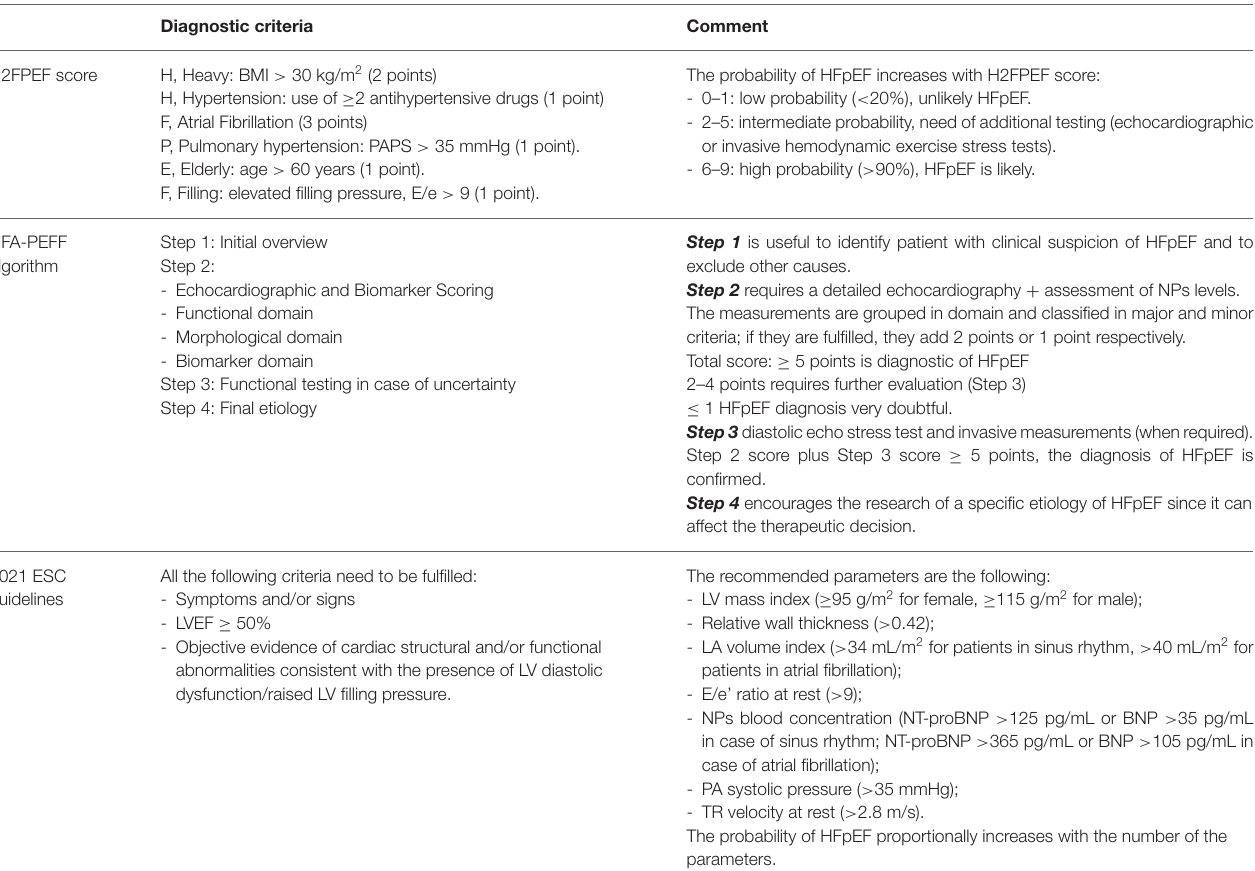
TABLE 2 | Proposed scores for diagnosis of